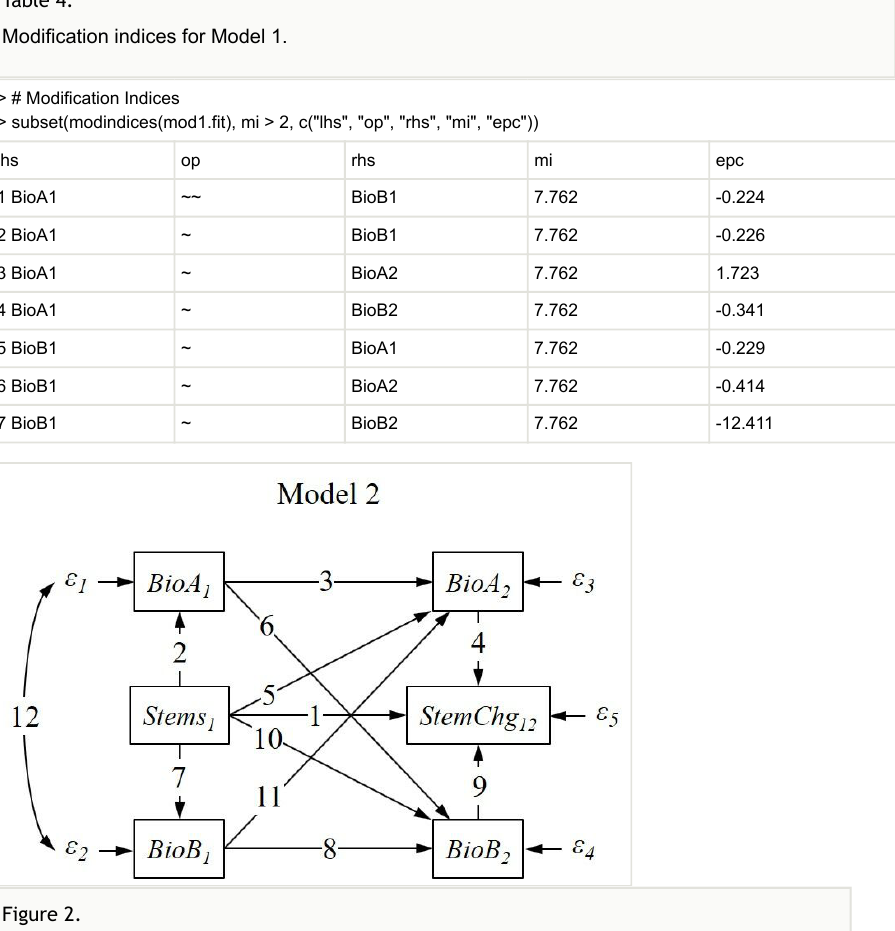
Modification indices for Model 1.